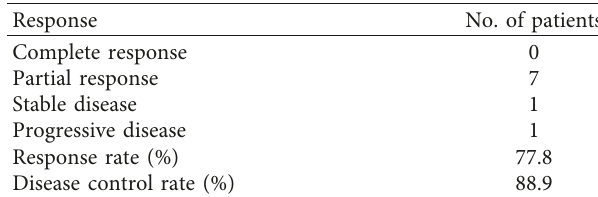
Table 3: Objective tumor